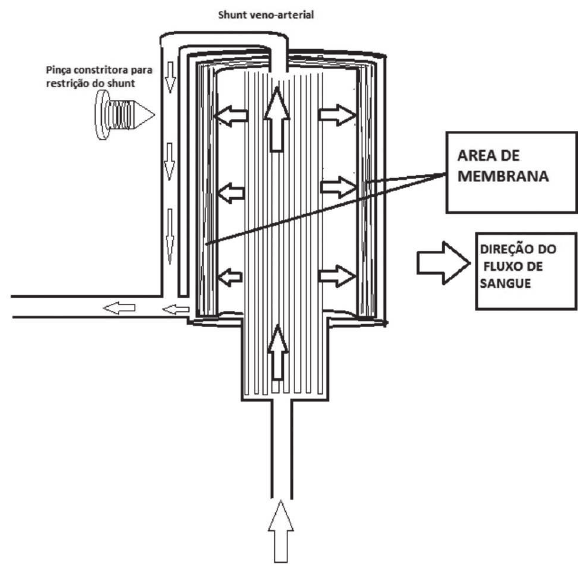
Fig. 5 - Dinâmica do sangue no oxigenador Oxyshunt. Desenho